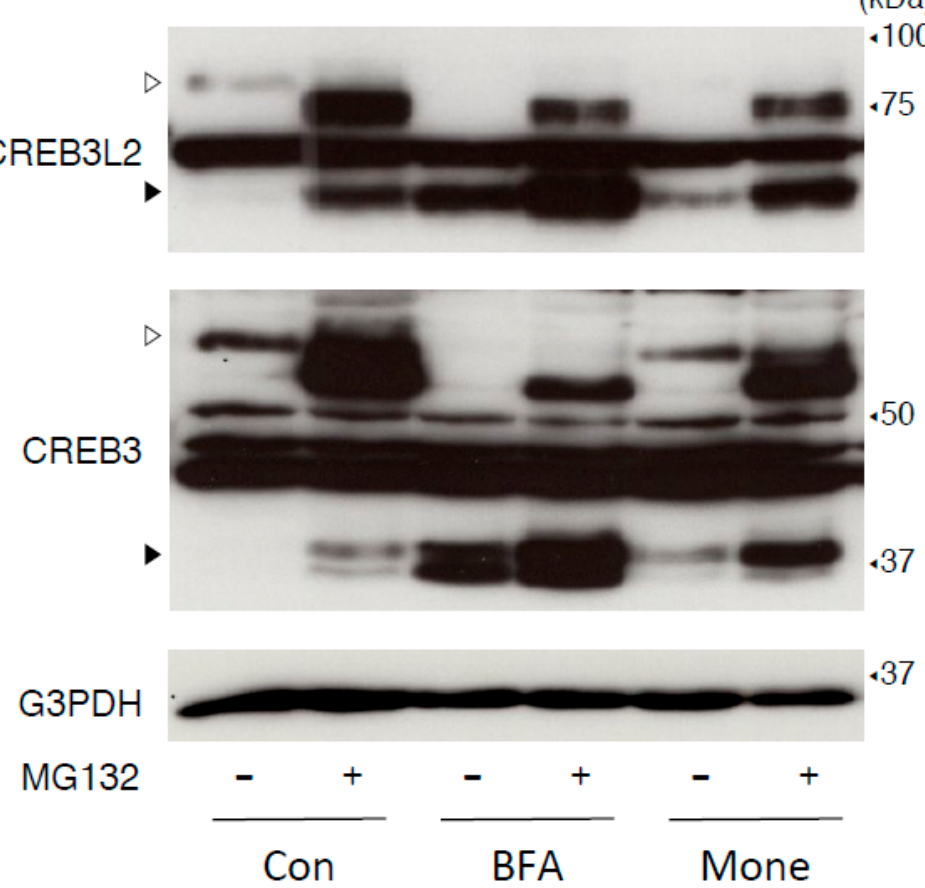
Figure 4. Effects of the MG132 treatment on the BFA- and monensin-induced processing of CREB3 and CREB3L2 proteins in HEK293 cells. HEK293 cells were treated with BFA (0.5 µ g/mL), monensin (1 µ M), or vehicle, in the presence or absence of MG132 (10 µ M), for 8 h. The expression of the indi- cated protein was detected as described in the Materials and Methods. Open and filled arrowheads indicate full-length mature and cleaved CREB3 and CREB3L2 proteins, respectively. Representative results of three independent cultures are